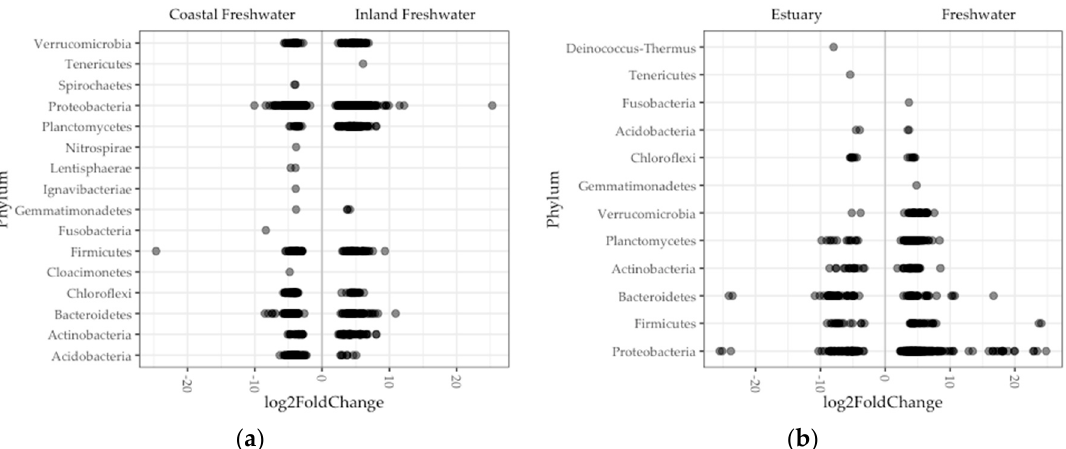
Figure 5. Significant di ff erential ASV abundance in fish gut microbiome was determined between: